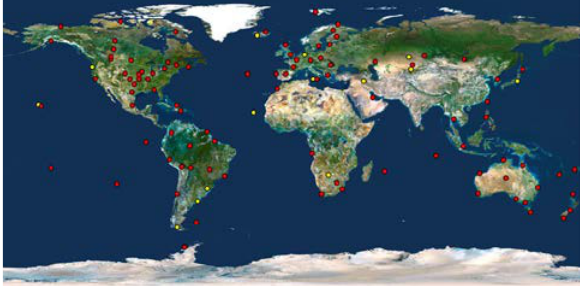
Figure 2: Trimble CenterPoint RTX Tracking